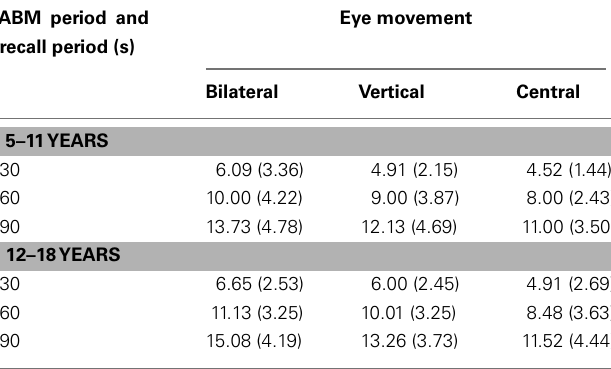
Table 1 | Mean (SD) number of episodic memories recalled as a function of eye movement condition, autobiographical memory period, and recall